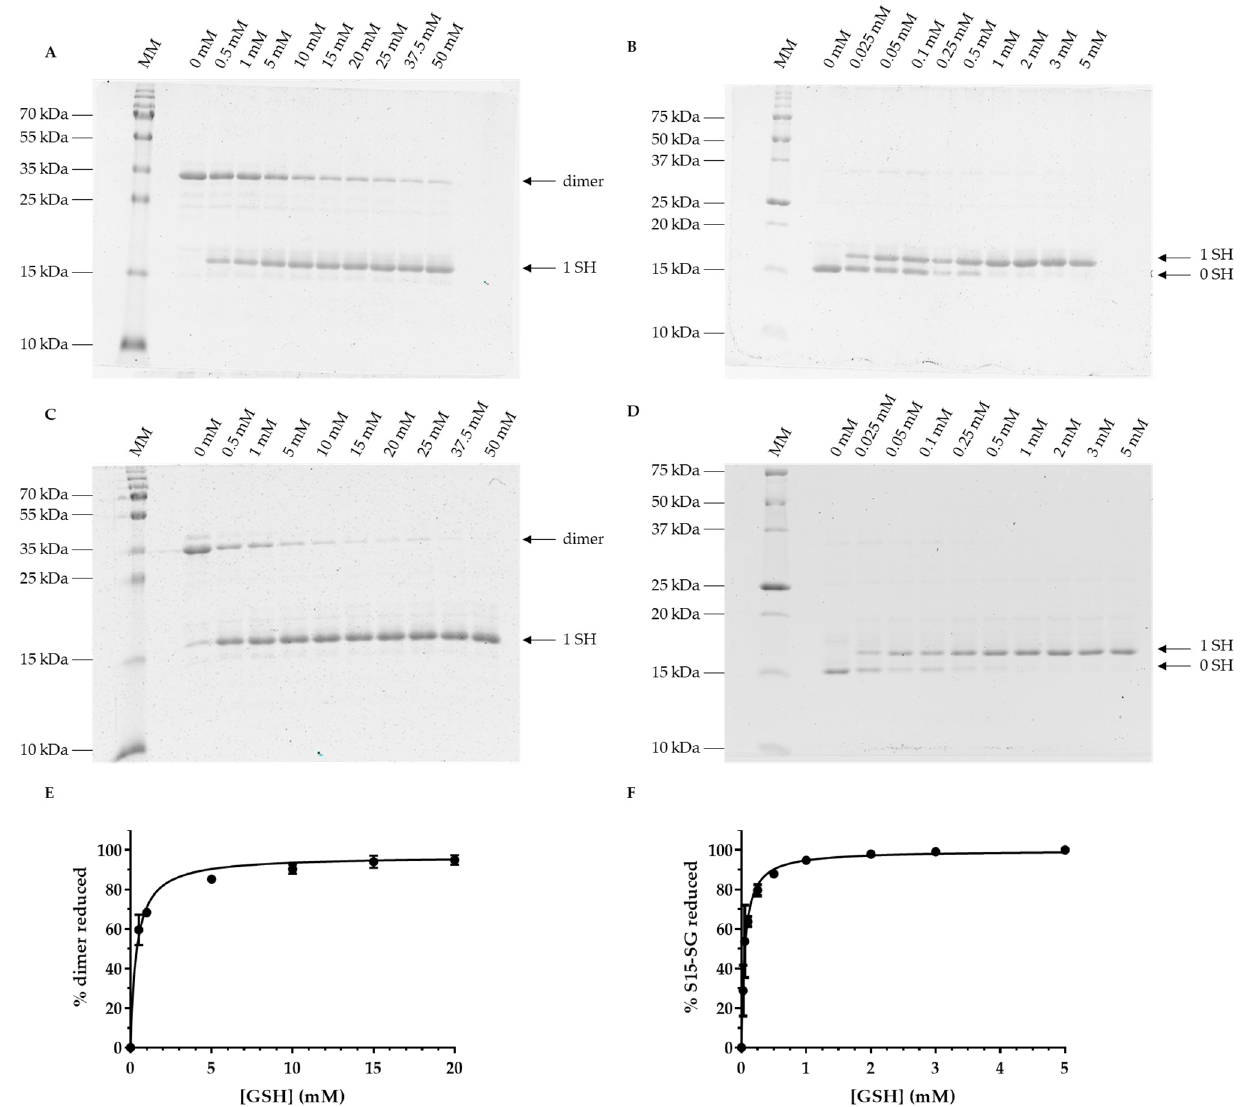
Figure 5. Reduction of oxidized At GRXS15 forms by GSH. Pre-oxidized recombinant At GRXS15 (13 µM), either dimeric ( A , C ) or glutathionylated ( B , D ), was incubated with 25 µM to 50 mM of GSH for 15 min ( A , B ) or 60 min at RT ( C , D ). Remaining reduced thiols were then alkylated before sample migration on non-reducing SDS-PAGE. The numbers on the right correspond to the number of thiols that were reduced upon treatment and thus were alkylated. Because the redox equilibrium between oxidized At GRXS15 and GSH was only complete for 60 min of incubation, gel bands were quantified for dimeric ( E ) and glutathionylated ( F ) At GRXS15 only at this time-point. The normalized intensities were transformed into % oxidized forms reduced respective to the minimum and maximum obtained and those values were plotted against GSH concentration. Gels are representative of at least three independent experiments and thus quantification represents the mean ± SD of three independent experiments.